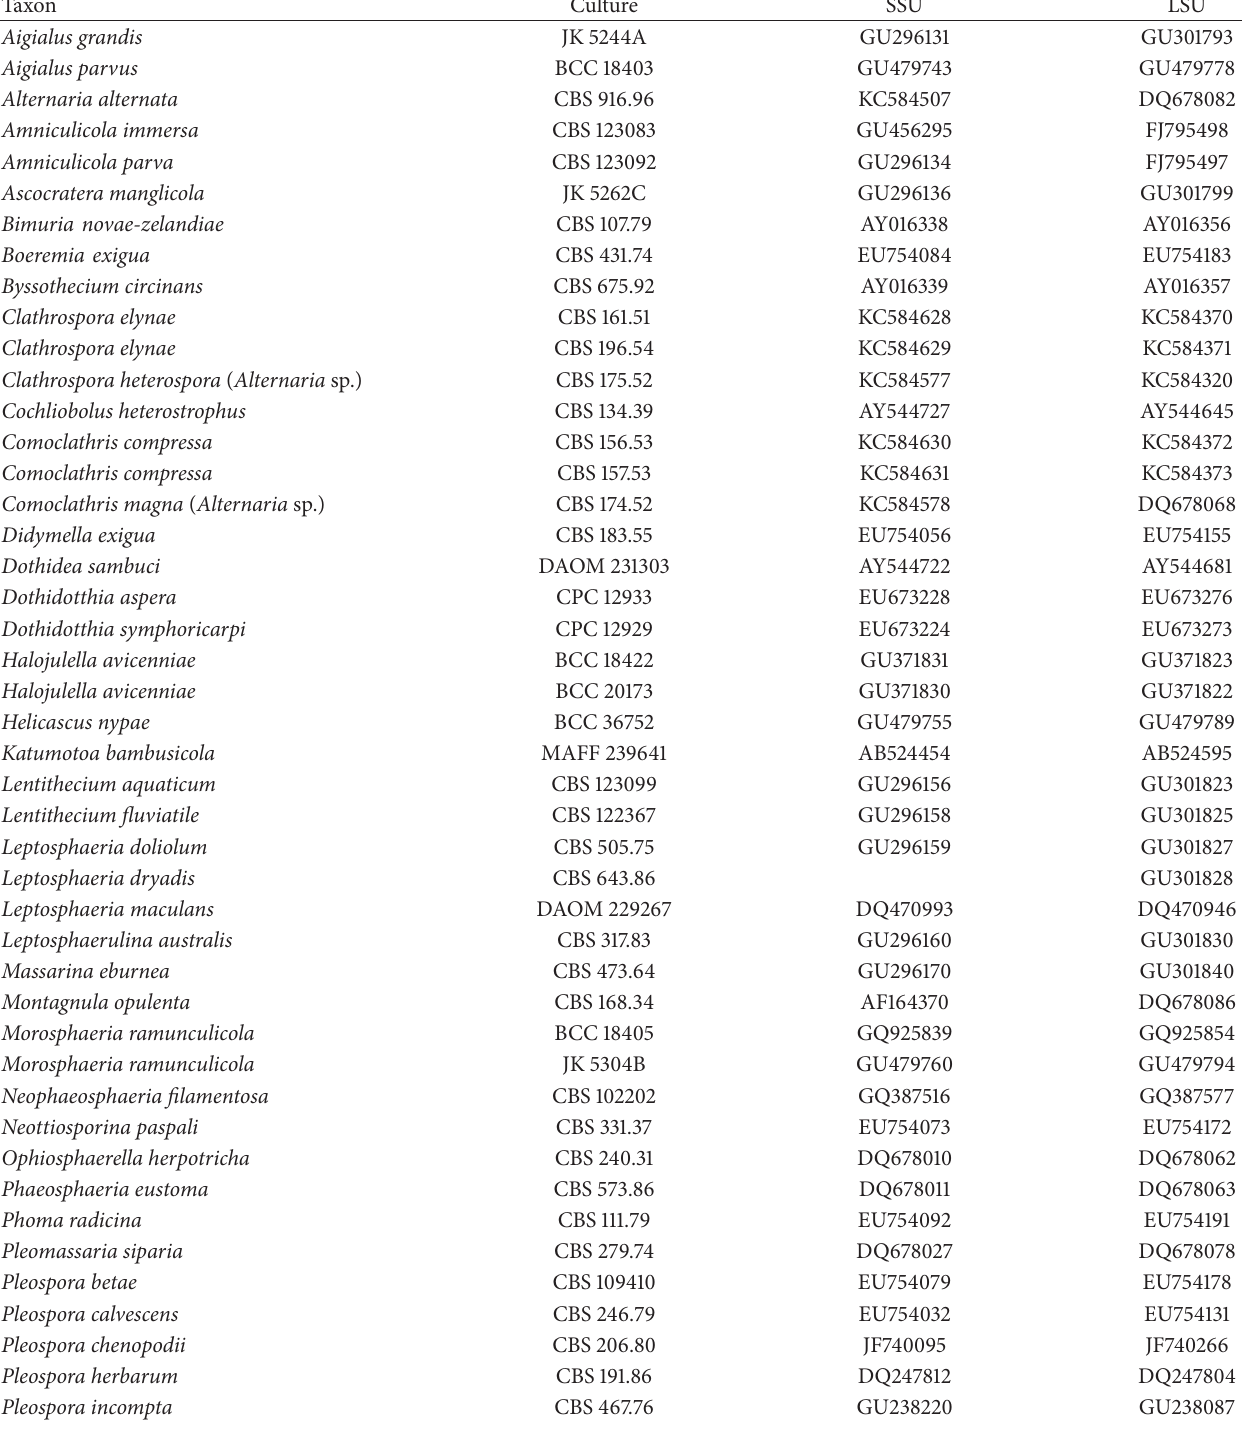
Table 1: Taxa used in the phylogenetic analysis and their corresponding GenBank numbers. Culture and voucher abbreviations are indicated where